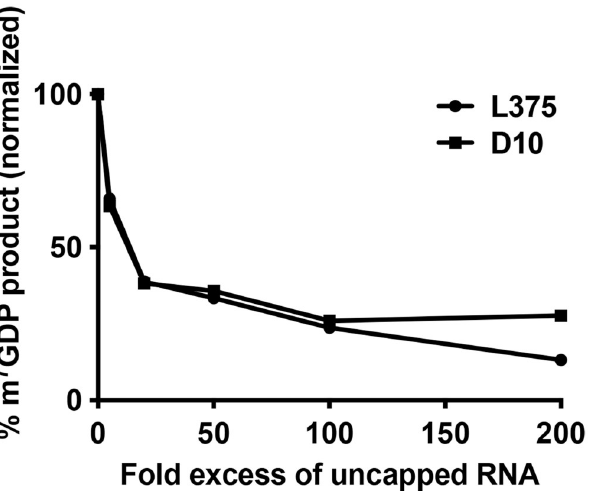
Fig 6. Recombinant L375 mRNA decapping activity is reduced by the addition of uncapped RNA competitor. 80 ng of recombinant L375 or VACV D10 and 0.02 pmol 32 P-cap-labeled 309-nt actin RNA were incubated with increasing amounts of uncapped, non-radioactive 309-nt actin RNA in mRNA decapping assays conducted as described in Fig 2B. The percentage of m 7 GDP product released was determined by using a